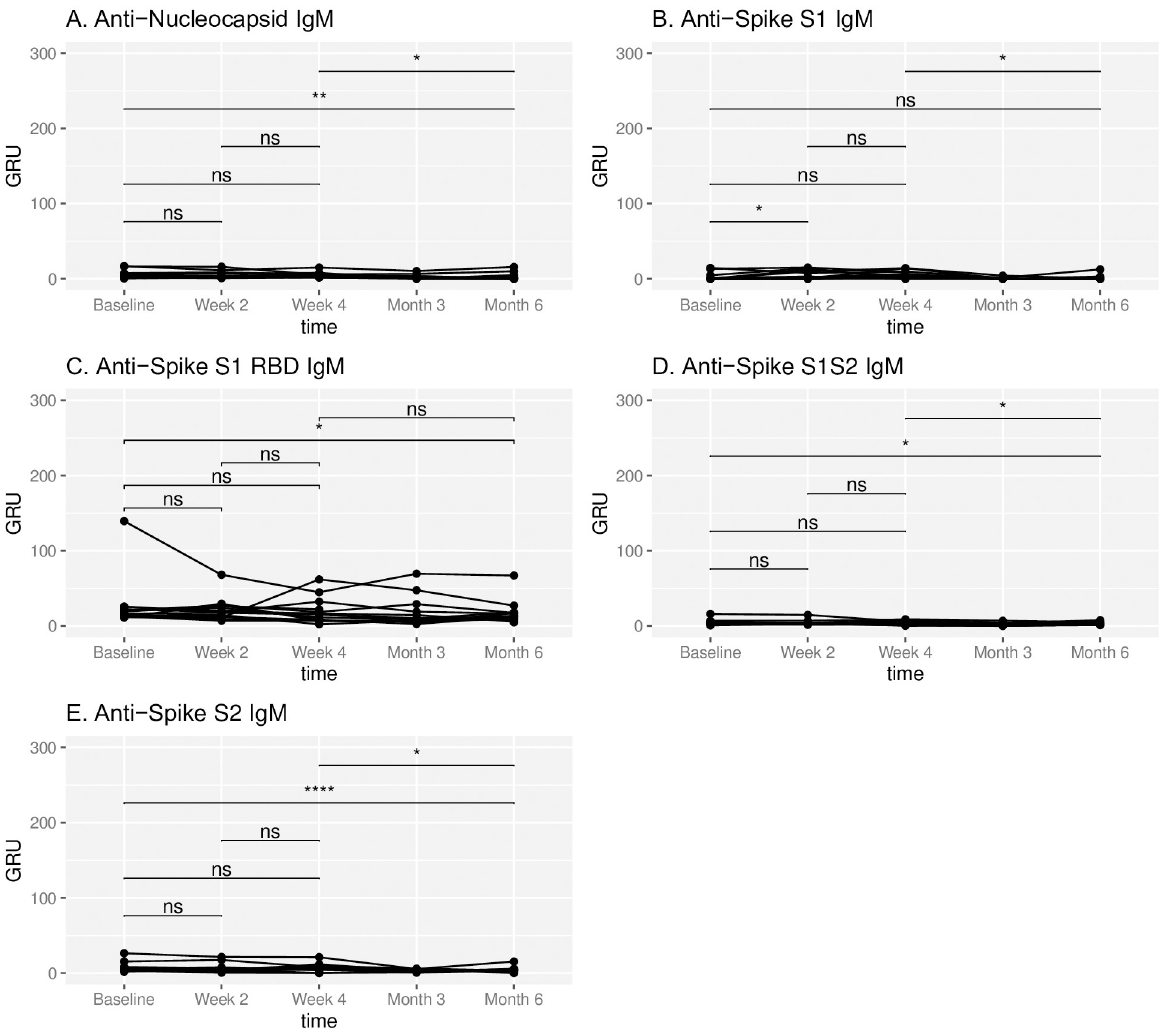
Fig 1. Temporal IgM response to SARS-CoV-2 epitopes. IgM antibody response to respective SARS-CoV-2 epitopes at baseline, week 2, week 4, month 3 and month 6 in subjects administered Pfizer-BioNTech COVID-19 vaccine at week 0 and week 3. Antibody response is reported in Genalyte response units (GRU). NS represents a p-value > 0.05, � represents a p-value � 0.05, �� represents a p-value � 0.01, ��� represents a p- value � 0.001, ���� represents a p-value � 0.0001.